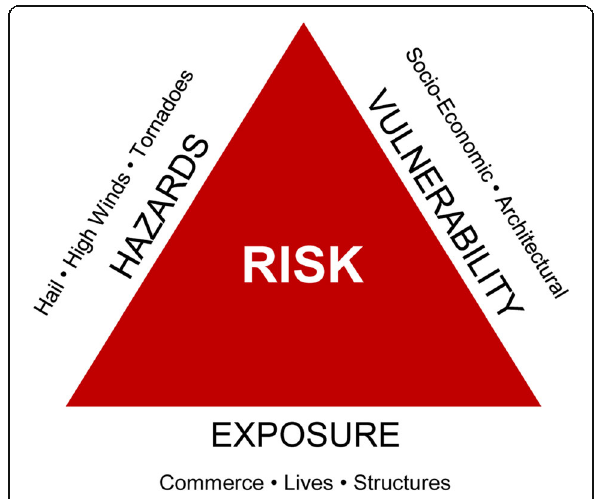
Fig. 3 The risk hazard triangle (adapted from Chrichton 1999). Hazards pose no risk if there is not some amount of exposure and